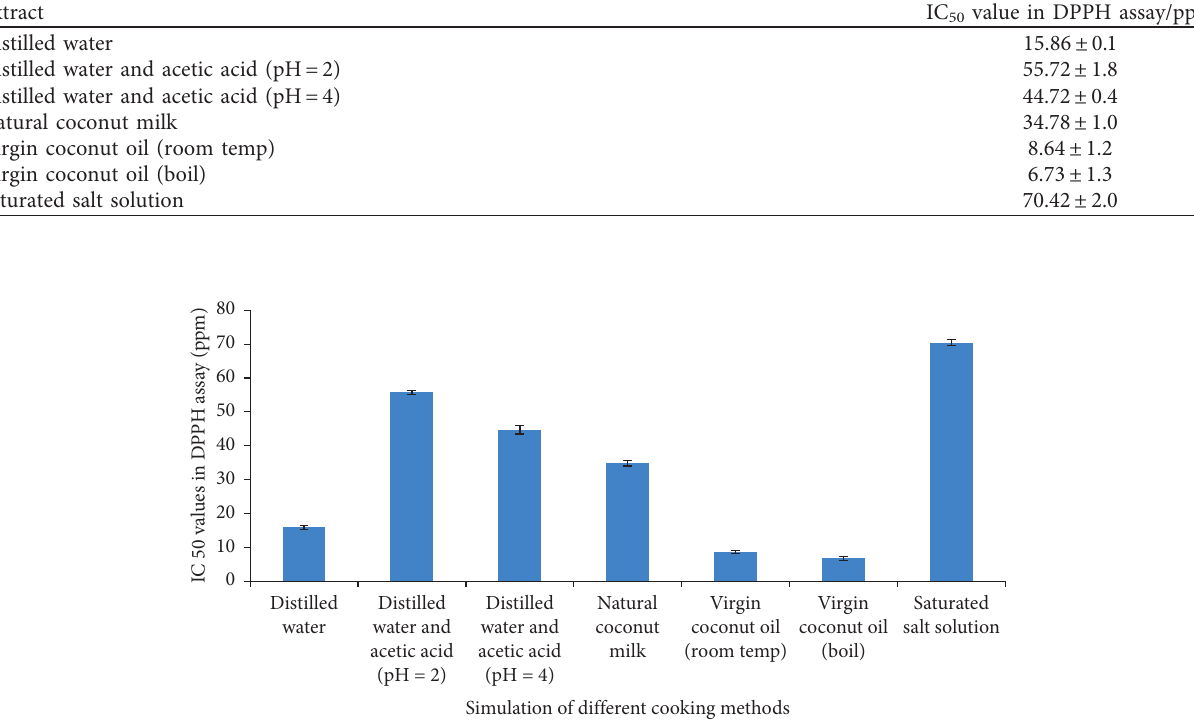
Figure 2: IC 50 values for different cooking samples in DPPH assay. Each data point is the triplicate mean.